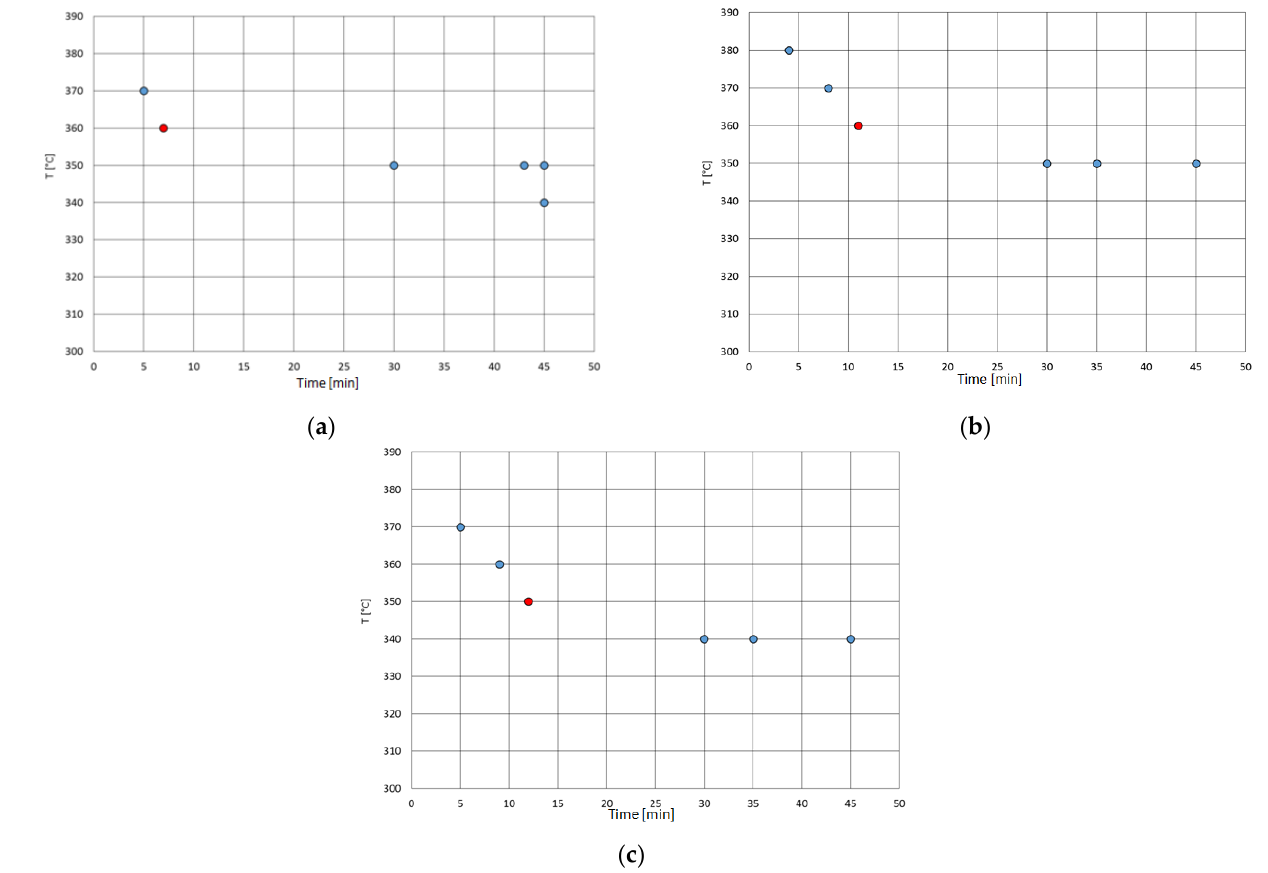
Figure 7. Determination of the ignition temperature of settled wood dust ( a ) from briquetting; ( b ) removed from the container; ( c ) removed from grinding. Table 6. Presentation of material parameters of spruce dust samples. 5 mm of Spuce Dust Layer Parameters